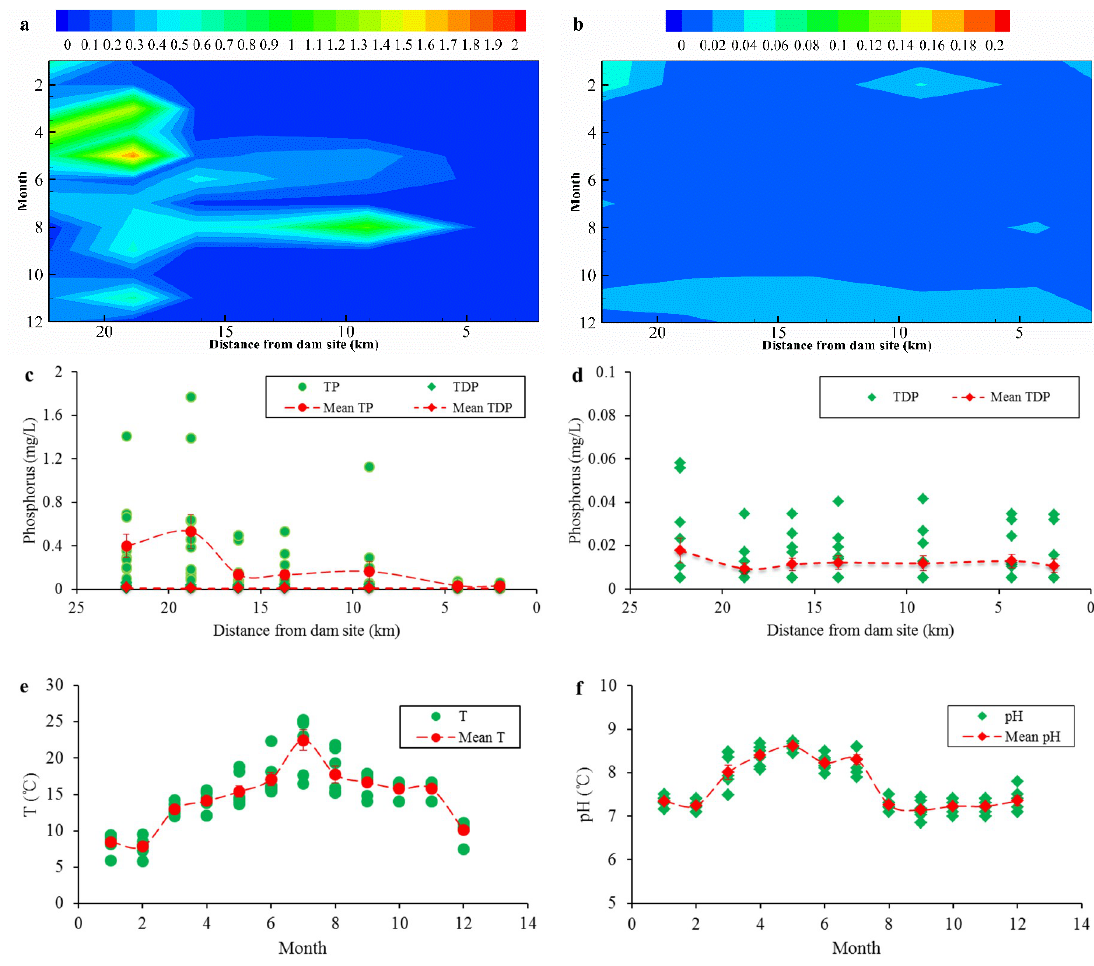
Figure 3. Environmental parameters of the overlying water in the Zipingpu Reservoir. ( a ) and ( b ) represent the spatial-temporal distribution of TP and TDP, respectively. Circles in ( c ) and ( d ) indicate TP and TDP values at different sampling sites and in different months. Circles in ( e ) and ( f ) indicate the temperature and pH of overlying water at different mouths. Both mean values with SE and individual values are exhibited in ( c – f ).